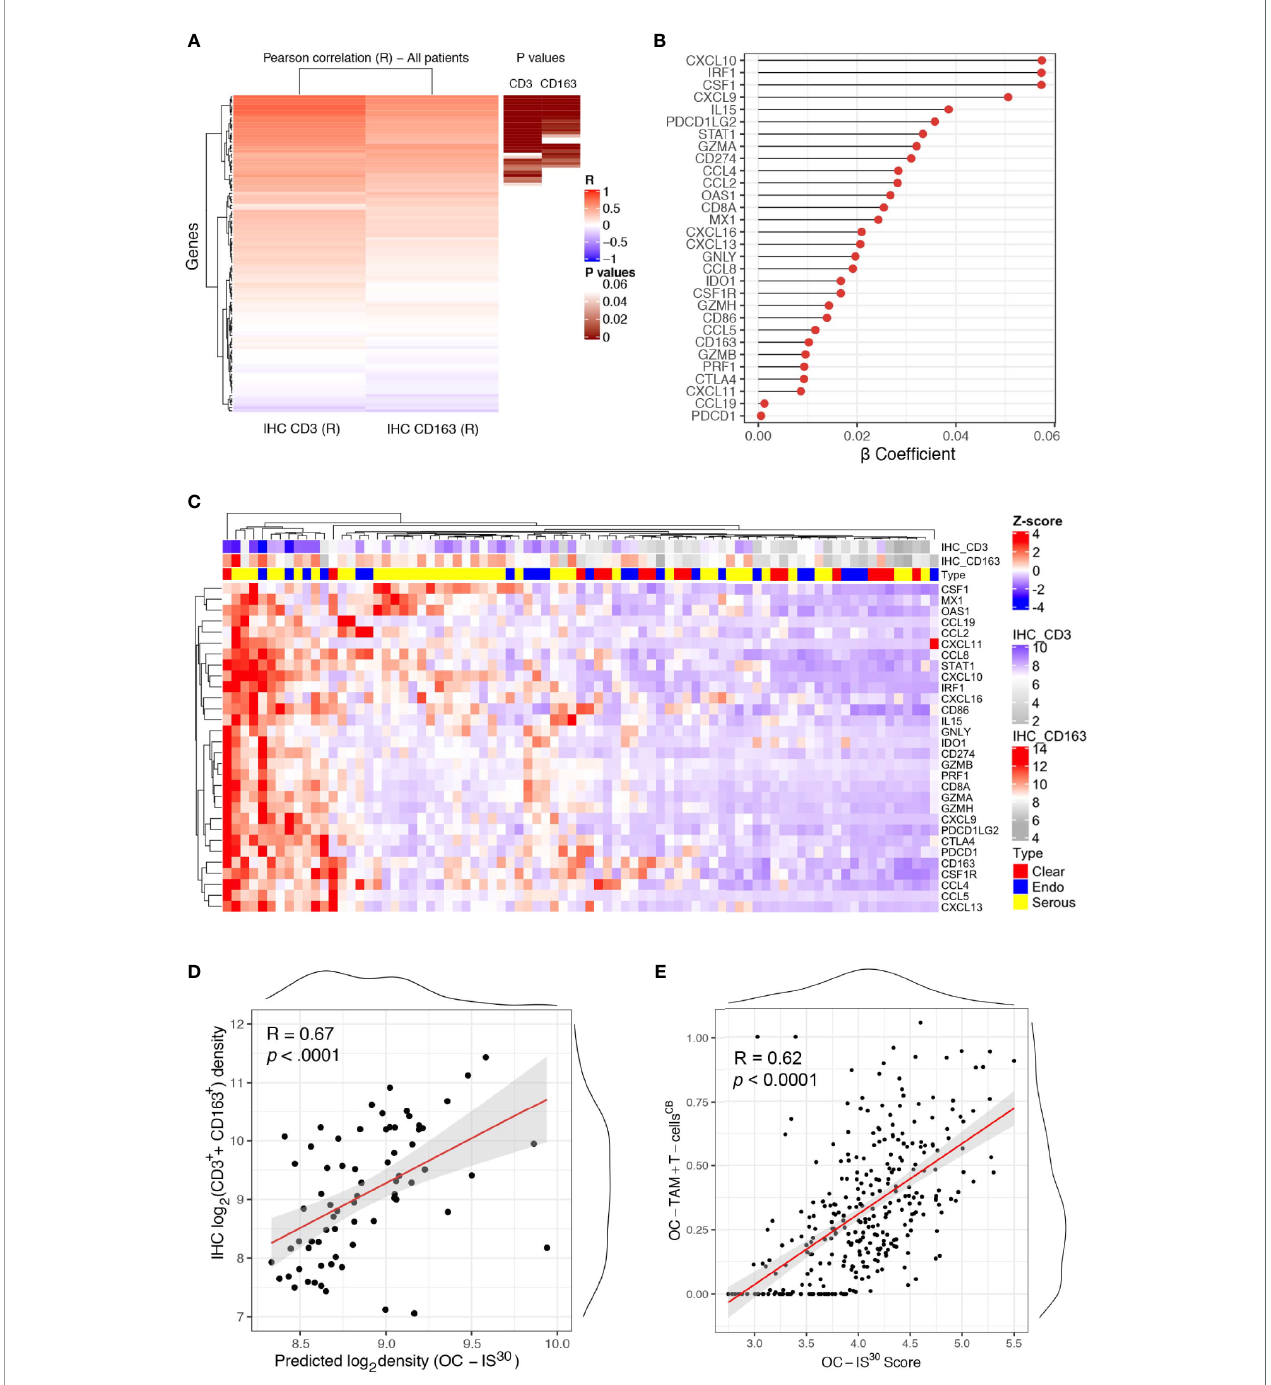
FIGURE 3 | OC-IS 30 identify in fl amed OCs. Heatmap of Pearson R coef fi cients of correlation analysis between log 2 Immune cells densities (for CD3 + T-cells and CD163 + TAMs) and log 2 normalized Nanostring gene signature. The 30 signi fi cant correlated genes (OC-IS 30 signature) are underlined in brown (Hommel adjusted p- values) (A) . Lollipop chart showing b coef fi cients of the penalized ridge linear regression, in descending order based on the weight of each gene, for the prediction of the sum of CD3 + and CD163 + density in the OCs cohort (B) . Heatmap of Z-score of OC-IS 30 signature in the OCs training cohort; top annotations showing histology subtype and CD3 + T-cells and CD163 + TAMs densities (C) . Scatter plot of the predicted OC-IS 30 density against the observed CD3 + T-cell and CD163 + TAMs density in the training cohort (R = 0.67, p < 0.0001) (D) . Scatter plot of the OC-IS 30 score against the sum of T-cell and TAMs fractions estimated by CIBERSORTx in the TCGA cohort (R = 0.62, p < 0.0001) (E)